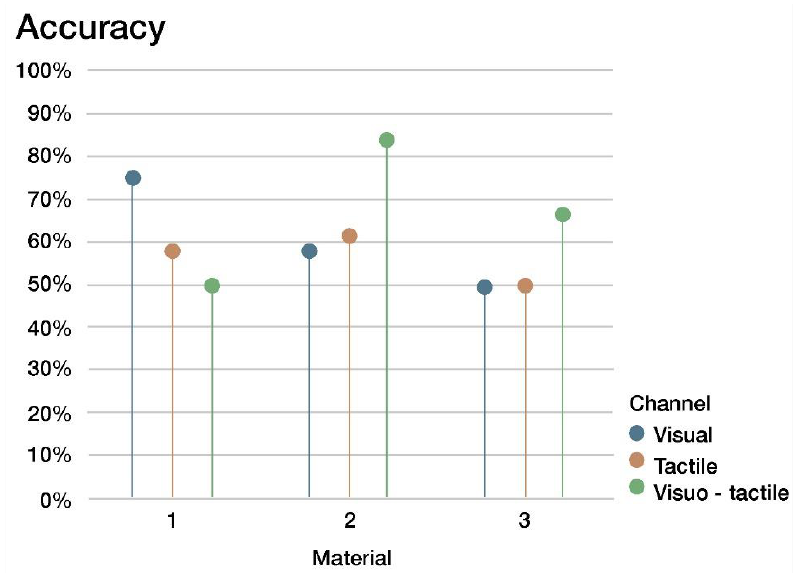
Figure 8. Accuracy in identifying materials when using different sensory channels. Table 1. Identification accuracy for each material and each presentation mode, with the results of a Chi-Square test for detecting statistically significant differences among presentation modes.